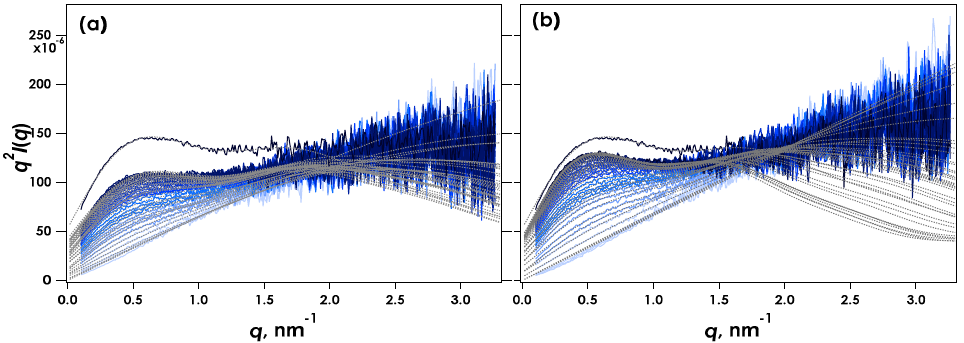
Figure 5. Kratky plots obtained for time-resolved SAXS during CLEX gelation of 1% alginate in aqueous MOPS buffer including CaEDTA and ZnEDDA at Ca 2+ = 30 mM and pH = 7.4. The results ( a ) and ( b ) correspond to independent measurements under the same experimental conditions. The profiles show data recorded every 5 s and the total trace times are 175 and 180 s for ( a ) and ( b ) respectively. Solid black lines indicate SAXS obtained from fully reacted gel samples following 10 h reaction